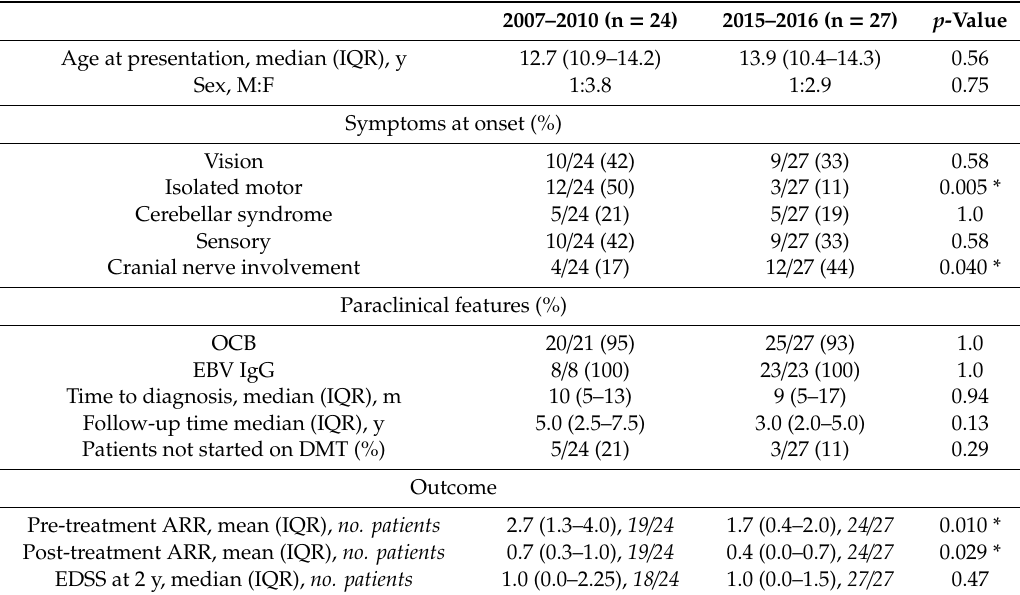
Table 1. Cohort characteristics, symptoms at onset and